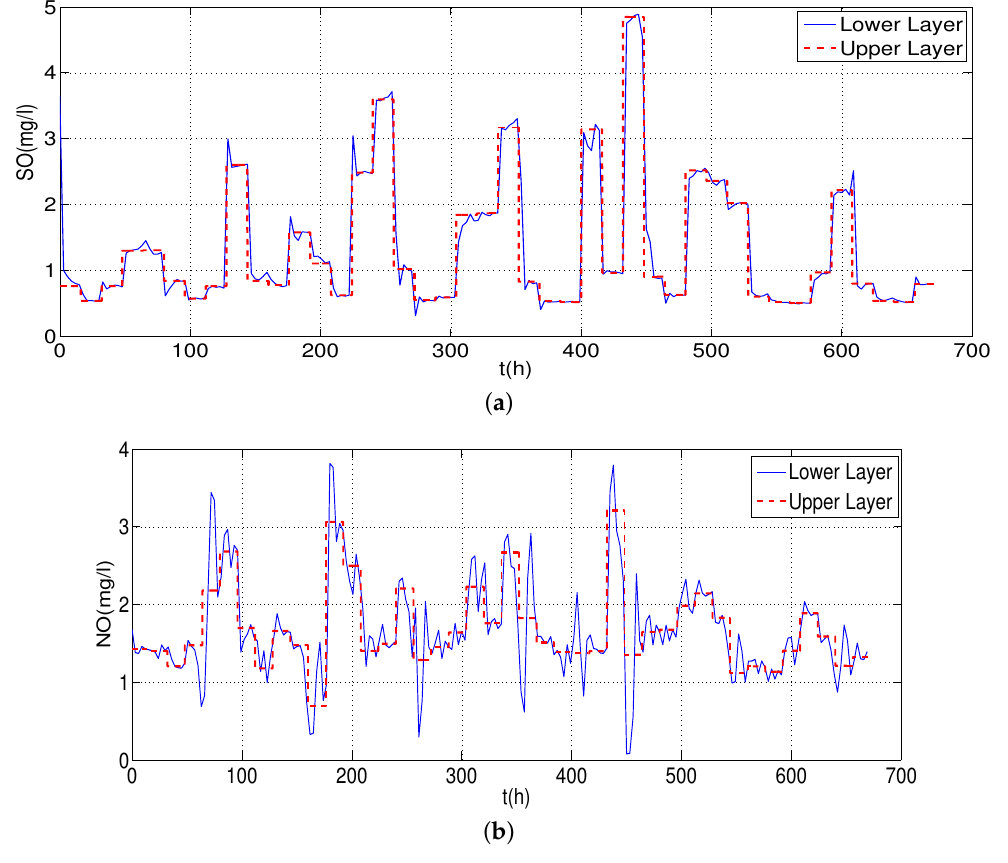
Figure 6. Responses of controlled variables under the proposed controller. ( a ) Dissolved oxygen concentration S O 2 , ( b ) Nitrite and nitrate concentration S NO .